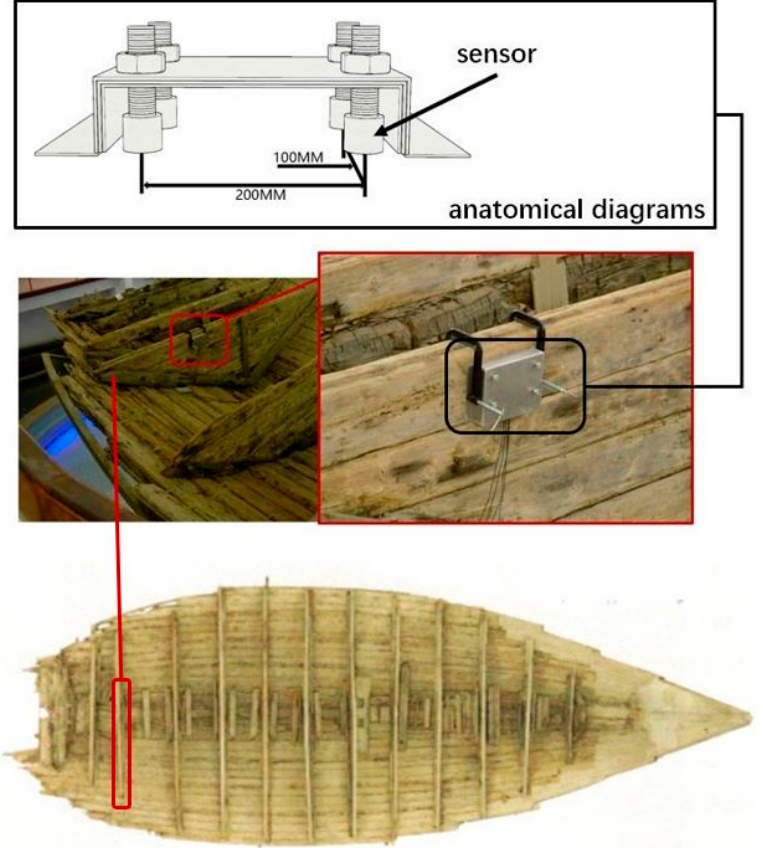
Figure 5. The shipwreck and four acoustic emission sensors coupled to the partition during on-site monitoring of the wooden object.